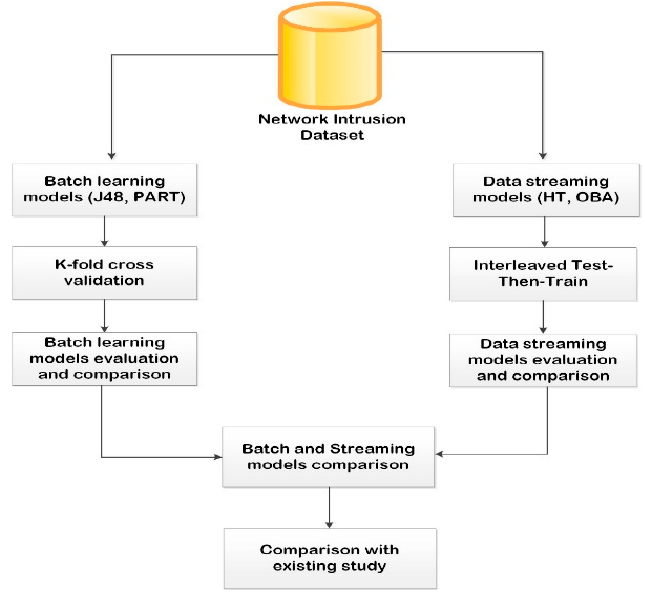
Figure 1. The experimental ML ‐ IDS framework.